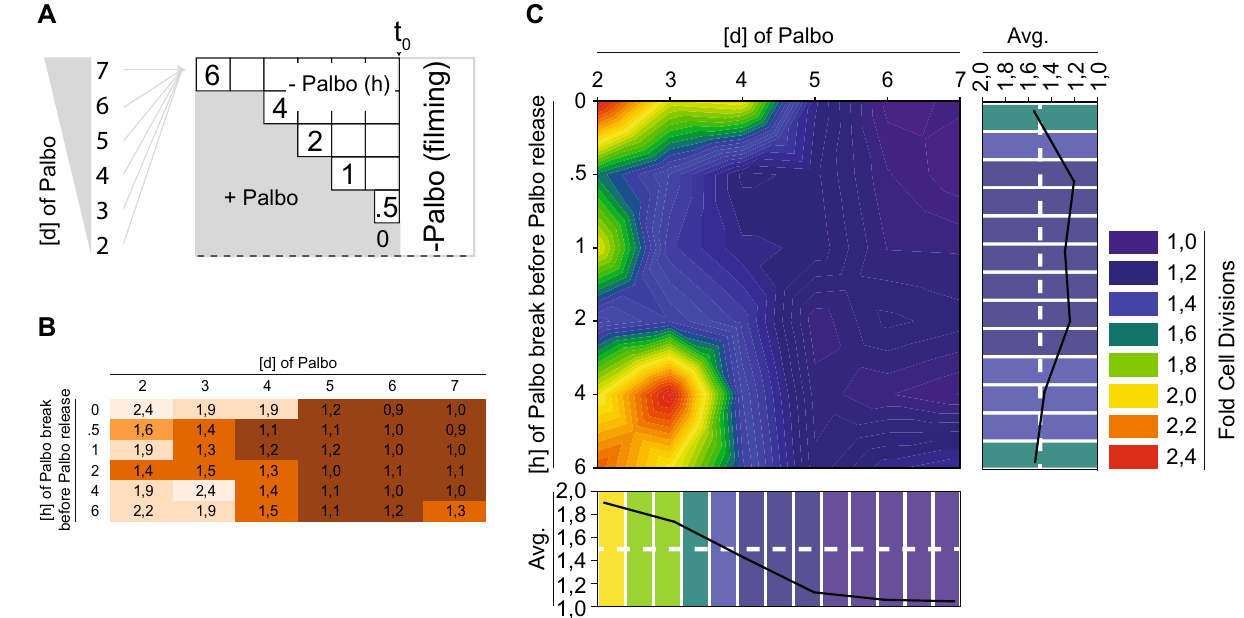
Figure 4. The Cdk4/6 phosphorylation gradient is time-sensitive. ( A ) Scheme visualizing the experimental set up of this figure. In short: cell were treated with Palbociclib for the indicated period of time (left), released for the indicated period of time (right) and subjected to time-lapse microcopy. ( B , C ) Single cells were traced and analyzed by their ability to undergo mitotic division. To ( B ) Normalized data (Fold Cell Division): 1 = no division, 2 = 1 division. To ( C ) Heat map of data from B. Color code represents an average cells ability to undergo mitotic division after being treated as in ( A